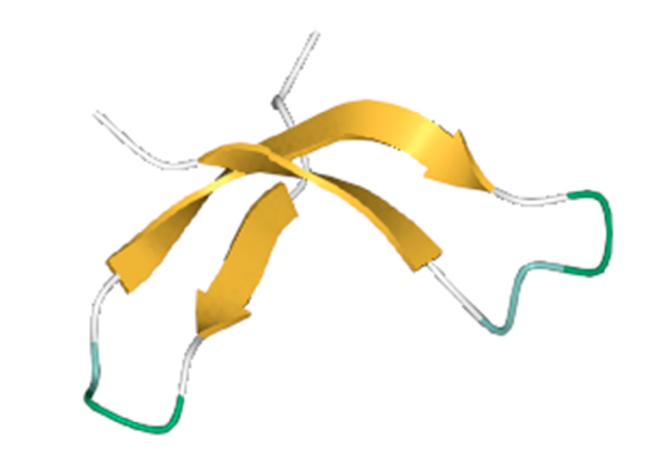
Figure 2. The binding sites of the BCR-ABL1 fusion protein predicted by DeepSite are shown by yellow arrows. Table 1. The binding sites center positions of BCR-ABL1 fusion proteins and their scores predicted by DeepSite.